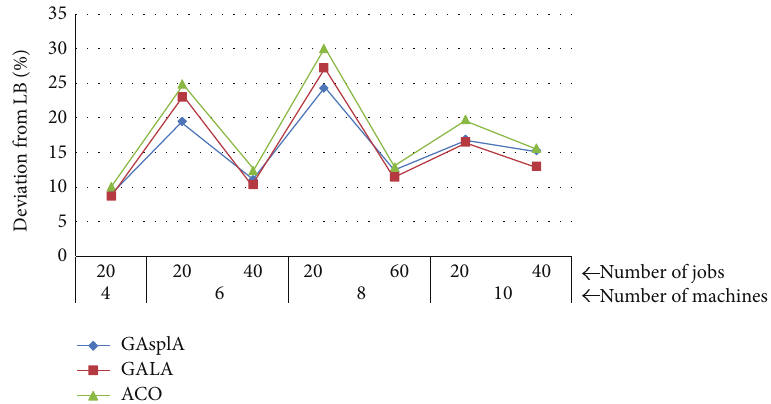
Figure 14: Deviation of each algorithm from the LB-large